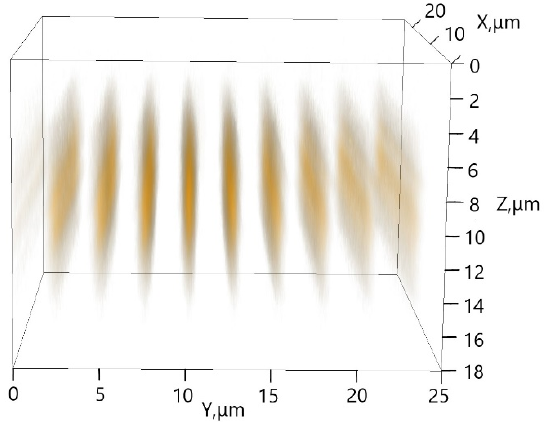
Figure 8. Three-dimensional PL image of a grating 10 µm thick with the QDs visualized using an LSM 710 laser scanning microscope. PL excitation wavelength, 405 nm.